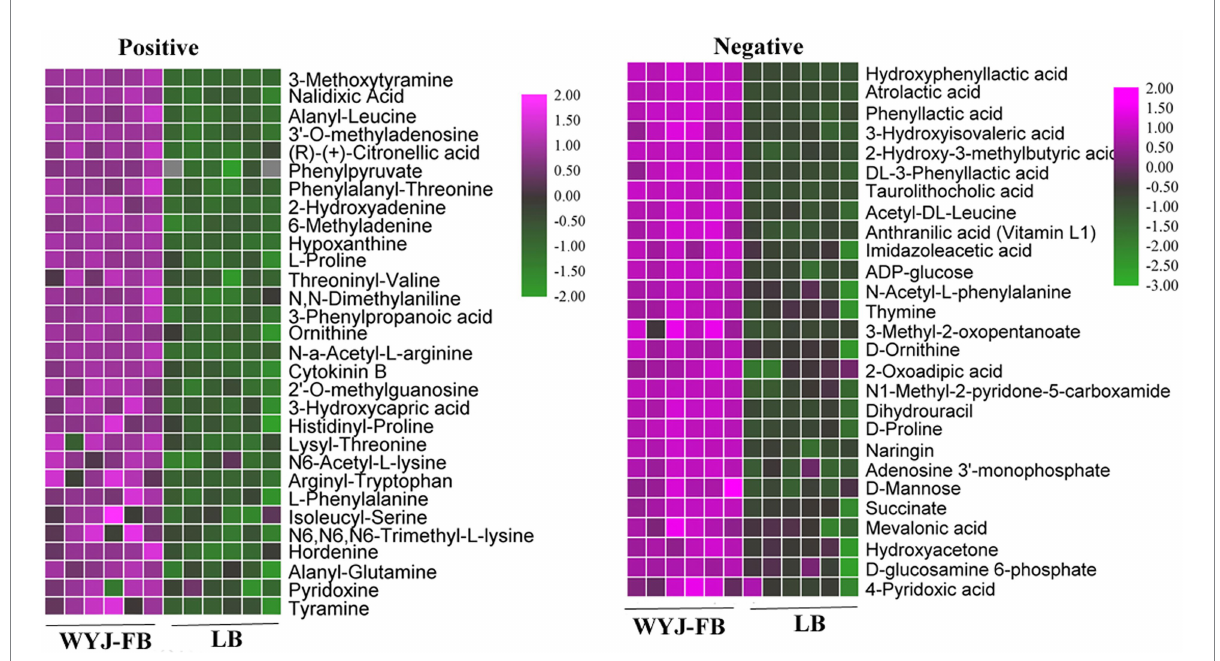
FIGURE 5 The heatmap of differential metabolites identified in positive ion modes and negative ion modes.